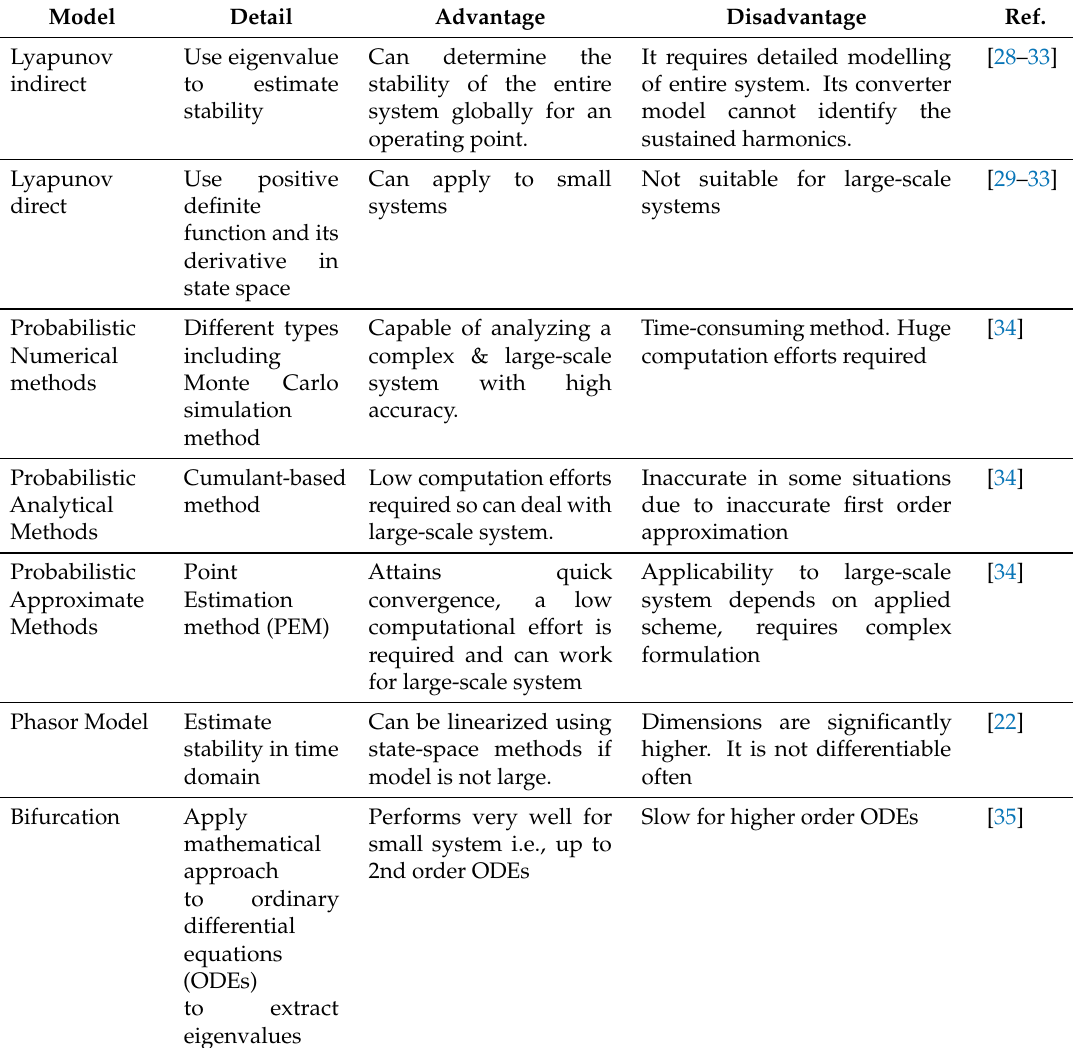
Table 1. Comparative Analysis of Different Stability Techniques in Time